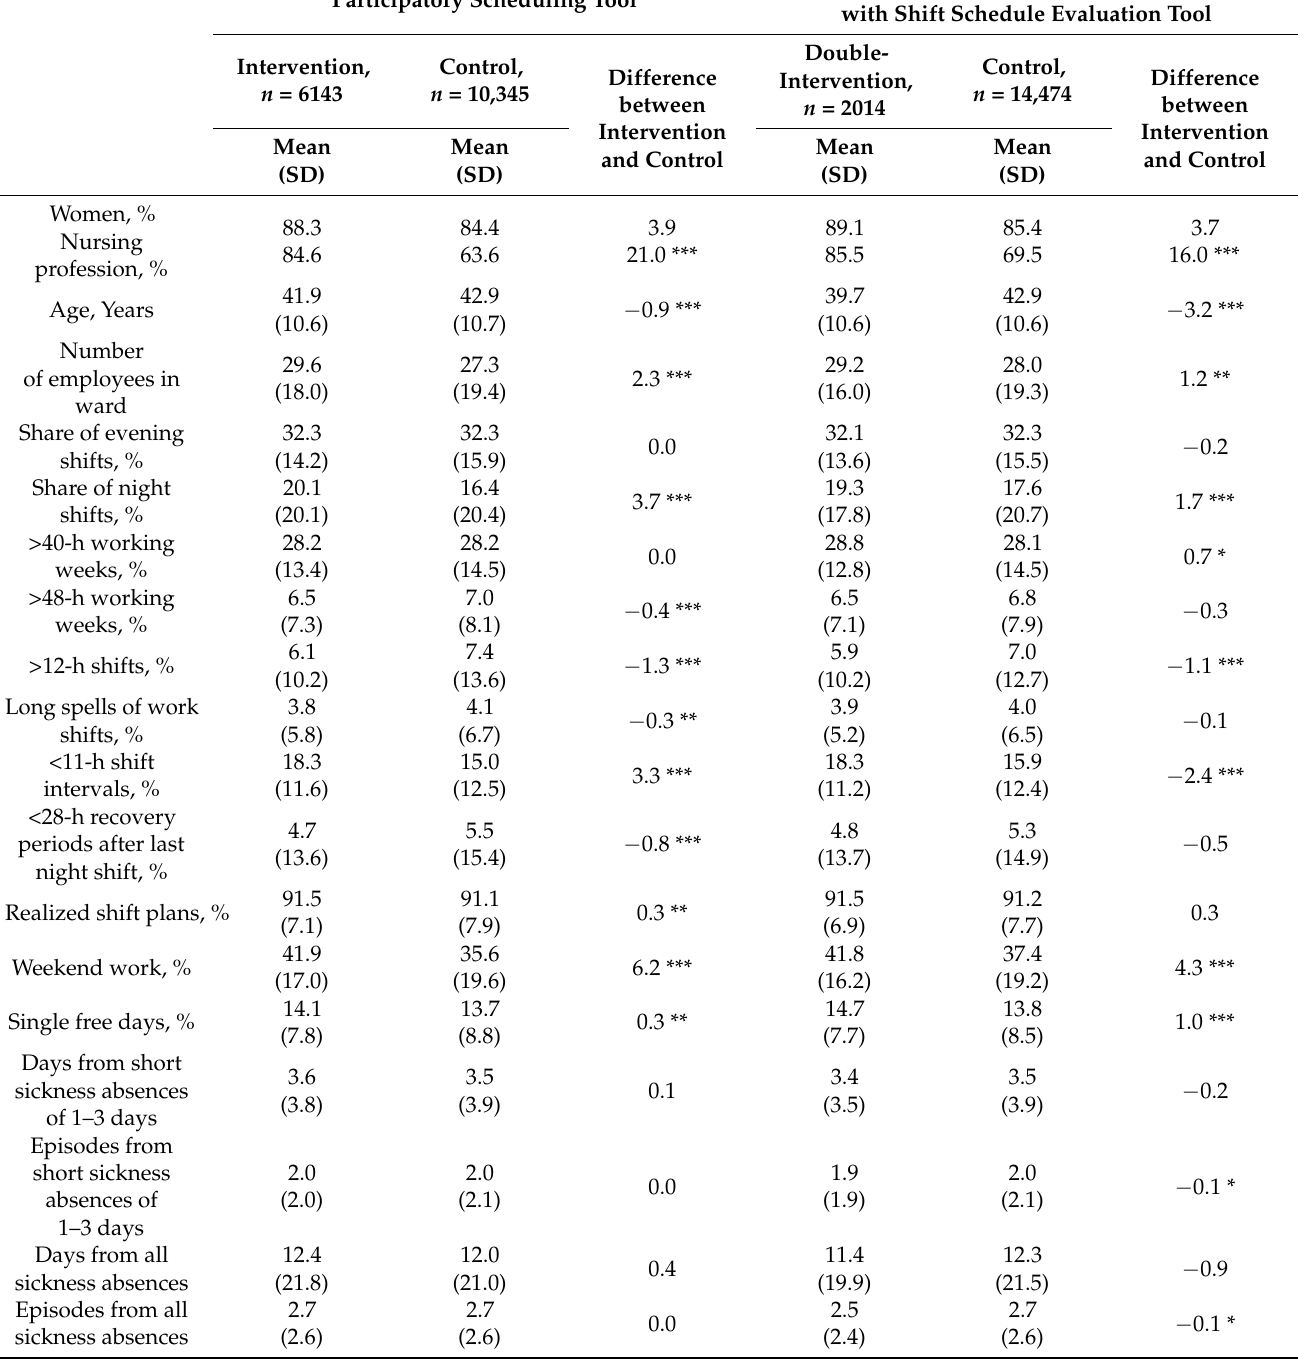
Table 1. Baseline characteristics (2015) of the intervention and never-treated control groups. n = 16,557. Left panel, the use of participatory scheduling tool, n = 6143 and 10,345. Right panel, the use of participatory scheduling tool with the shift schedule evaluation tool, n = 2014 and 14,474. Note that *, **, *** denote statistical significance at 0.05, 0.01, and 0.001 levels, respectively. The Secondary Intervention, i.e., The Primary Intervention, i.e., the Use of the the Use of the Participatory Scheduling Tool Participatory Scheduling Tool with Shift Schedule Evaluation Tool Double- Control, Intervention, Control, Difference Difference Intervention, n = 14,474 n = 6143 n = 10,345 between between n = 2014 Intervention Intervention ControlMean and and Control